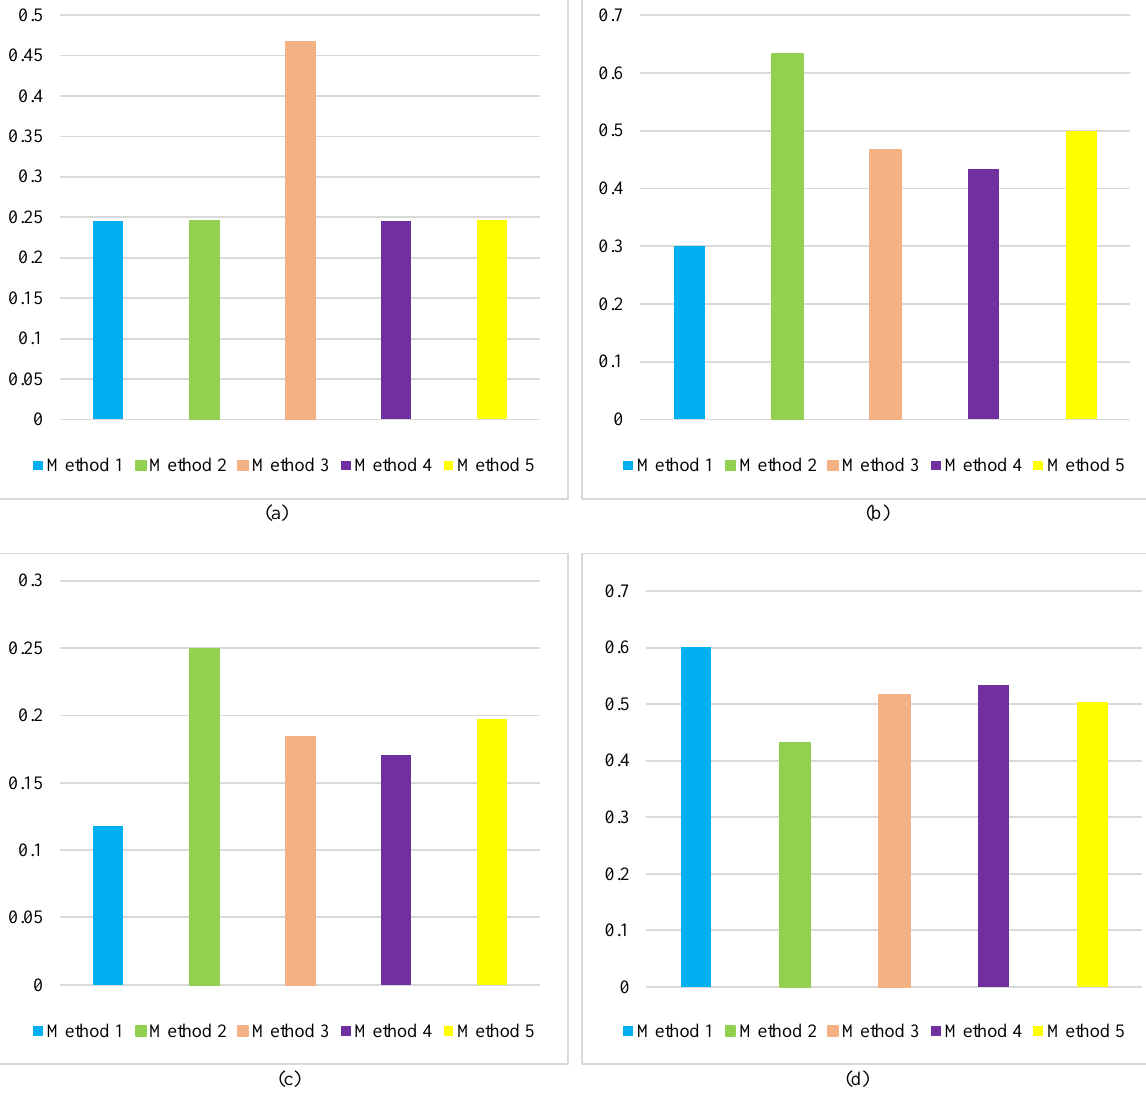
Figure 7. Comparison between the proposed method and other methods based on (a) recall, (b) precision, (c) F 1 score, (d)